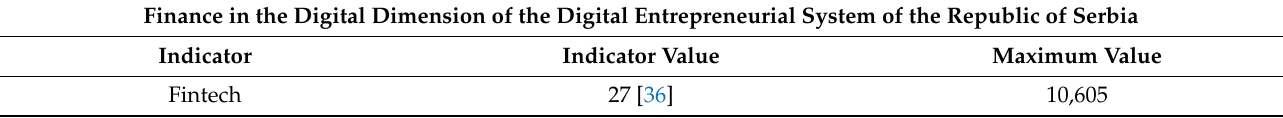
Table 6. The components of finance in the digital dimension—the scale-up phase of an enterprise (the table refers to the Republic of Serbia and was made in the likeness of the EIDES report).